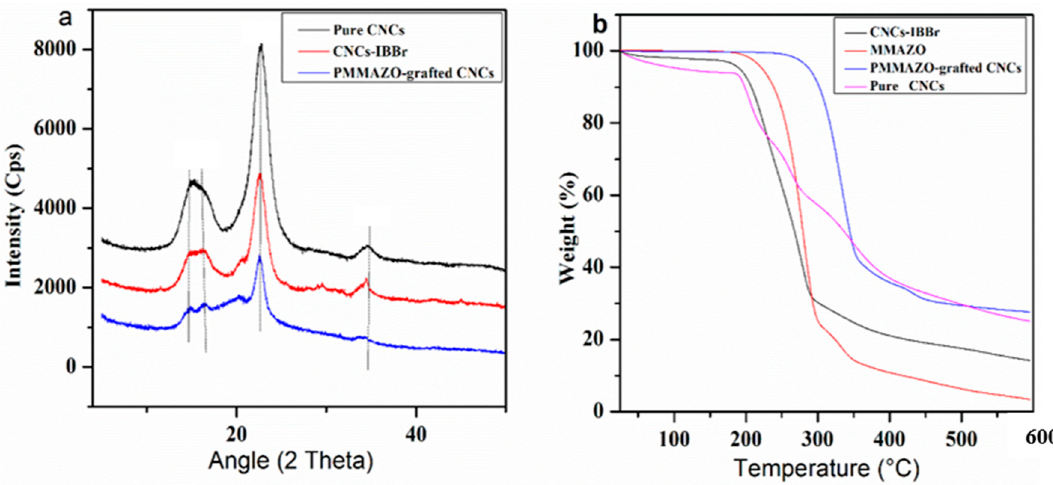
Figure 6. XRD pattern ( a ) of pure CNCs, CNCs-IBBr and PMMAZO-grafted CNCs; and ( b ) the TG